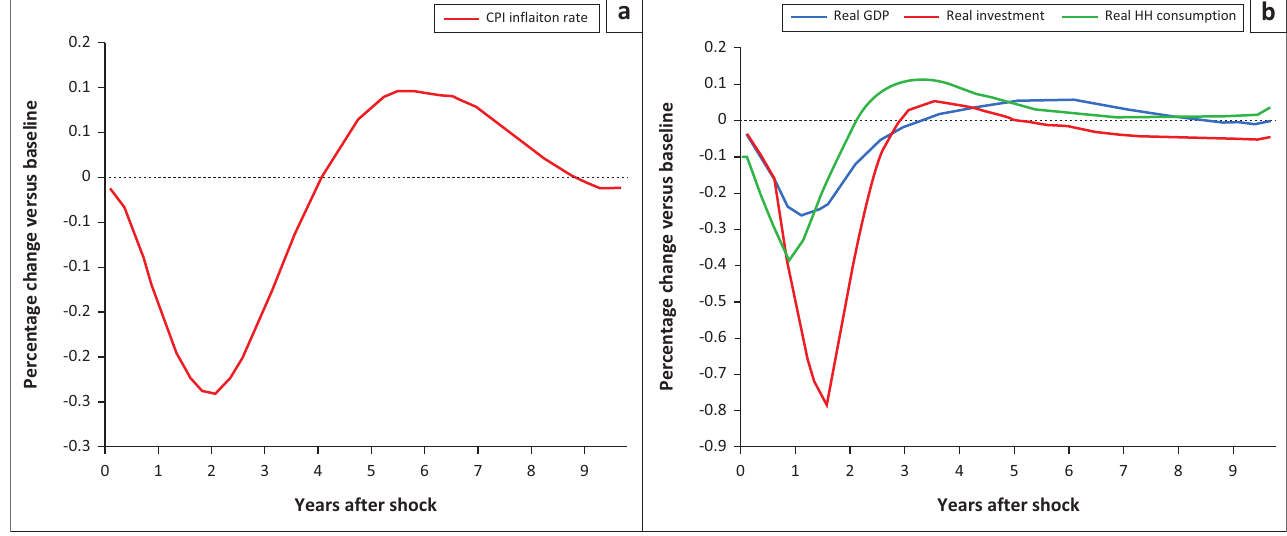
FIGURE 5: Model response (a–b) to four-quarter real repo rate